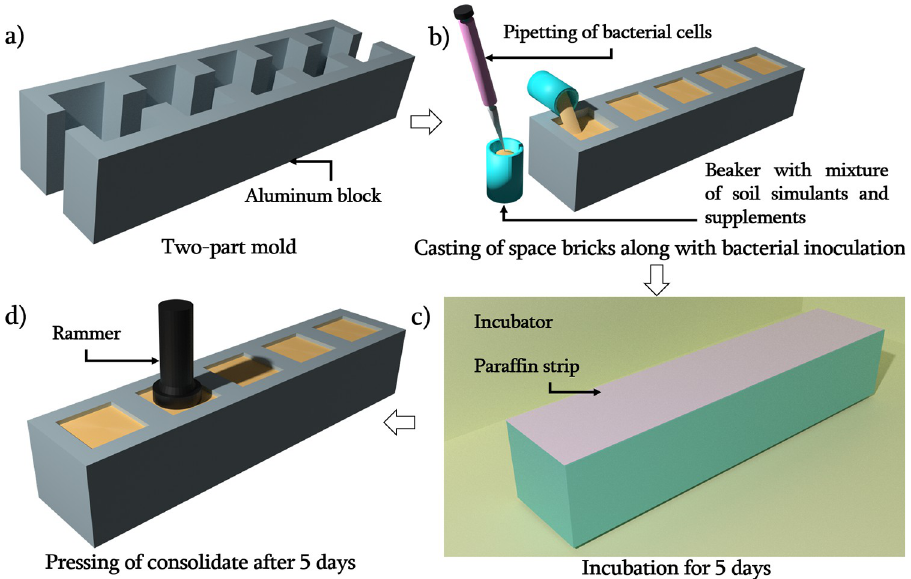
Fig 1. Schematic representation of casting of aluminium mold and process involved in MICP mediated consolidation of simulant soils.